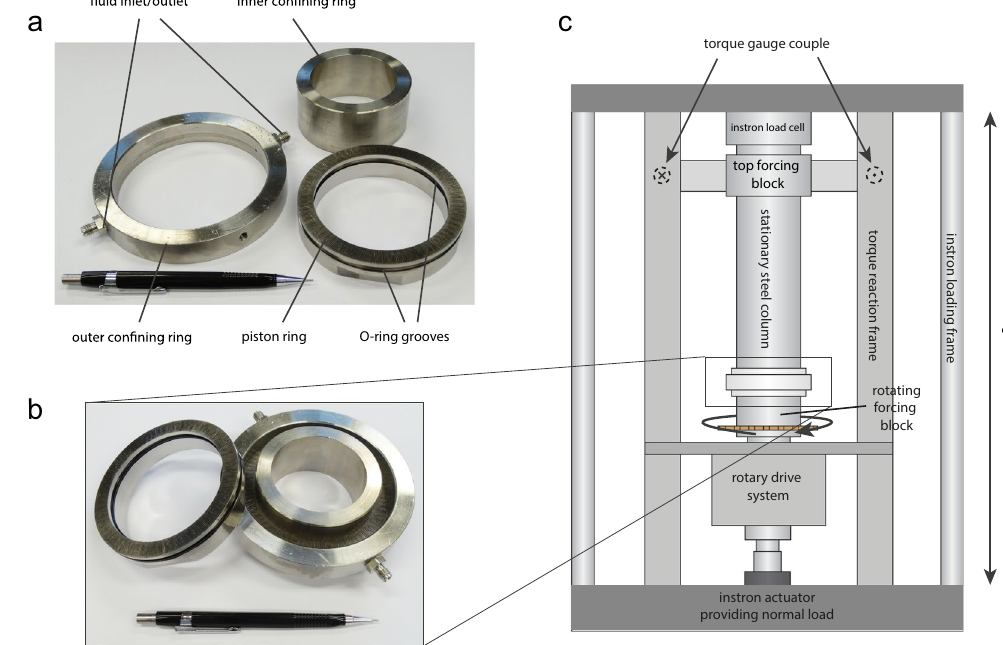
Figure 4. Overview of the sample assembly and apparatus used. ( a ) Photograph of one piston ring and the inner- and outer stainless steel confining rings. The pen for scale has a length of 14.5 cm; ( b ) Photograph of partially assembled sample. The gouge is deposited on the piston ring that is confined by the stainless steel rings (right). The second ring (left) is placed on top of the gouge to close off the assembly; ( c ) Schematic diagram of the rotary shear